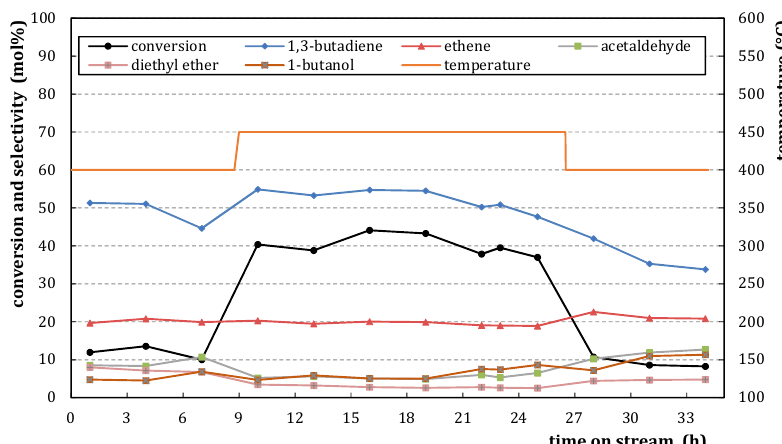
Figure A5. Results of catalytic testing of M3(24)/SiO 2 90:10; produced according to Section 3.3. with 24 h autoclave treatment duration ( m cat = 500 mg; WHSV = 4.7 h − 1 ; T = 450 °C; p = 5.5 bar(a); (cid:1848)(cid:4662) (cid:2898) l/h). The catalyst showed only very little deactivation.